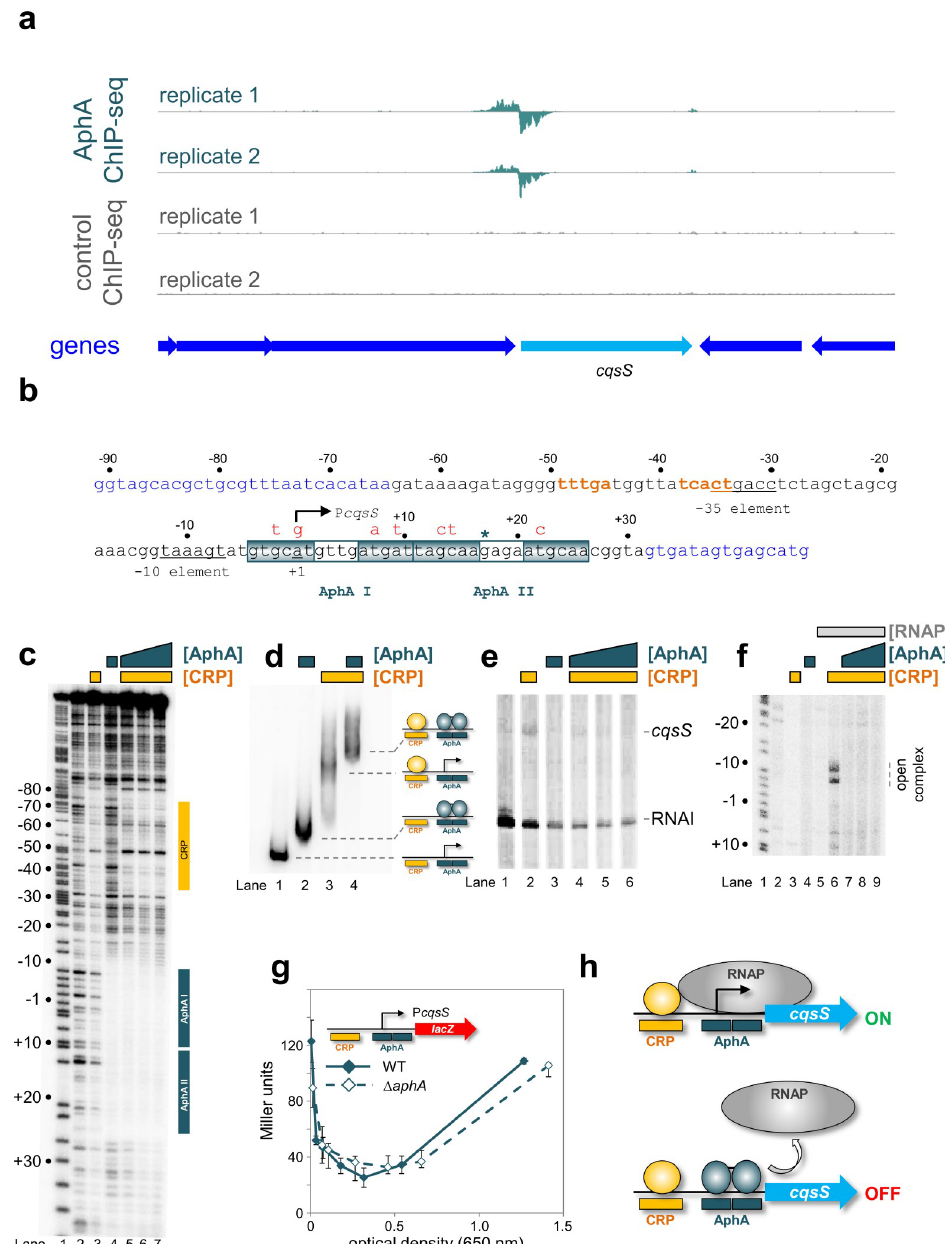
Fig 4. Interactions between AphA, CRP and the cqsS regulatory region. (a) AphA binds upstream of cqsS in vivo . Genes are shown as block arrows. ChIP-seq coverage plots are shown for individual experimental replicates. Data for AphA are in teal and control profiles are grey. Signals above or below the horizontal line correspond to reads mapping to the top or bottom strand respectively.(b) Sequence of the cqsS intergenic region. Coding DNA is in blue. Promoter elements are underlined and labelled. The transcription start site is shown as a bent arrow. Distances are with respect to the cqsS transcription start site. The CRP binding site is in orange and AphA binding sites are boxed. The centre of the AphA ChIP-seq peak is denoted by a teal asterisk. Mutations introduced into each AphA site are shown in red above the sequence.(c) AphA and CRP bind distinct sites at P cqsS . The gel shows the result of a DNase I footprint using a DNA fragment containing P cqsS . A Maxim-Gilbert ‘G+A’ ladder has been used to calibrate the gel (lane 1). The addition of 3 μ M CRP produces a footprint indicated by the yellow vertical bar (lane 3). The vertical teal bar indicates the footprint formed in the presence of 1 μ M AphA (lane 4). The CRP footprint is not altered by increasing concentrations of AphA (lanes 5–7, CRP concentration: 3 μ M, AphA concentrations: 1, 2, 3 μ M).(d) AphA and CRP bind to P cqsS simultaneously. The gel shows the result of electrophoretic mobility shift assay using a DNA fragment containing P cqsS . Data are shown for the DNA alone (lane 1), or in the presence of 1 μ M AphA (lane 2), 3 μ M